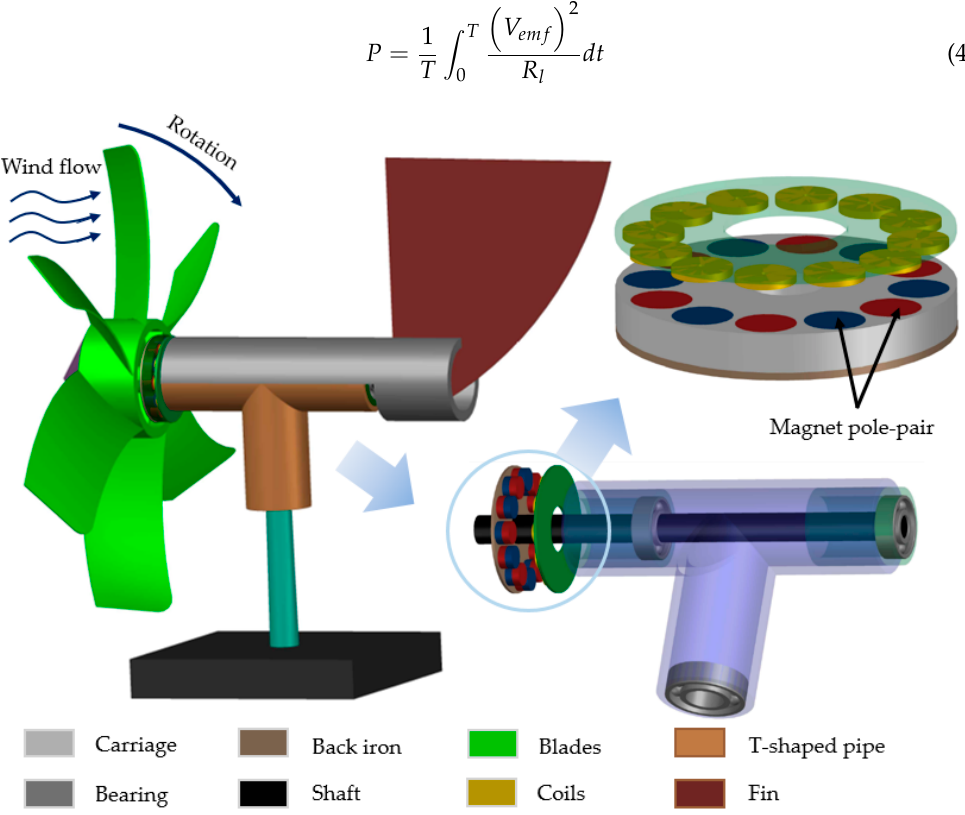
Figure 1. Schematic structure of the proposed electromagnetic wind energy harvester (EMWEH) using magnet pole-pairs.